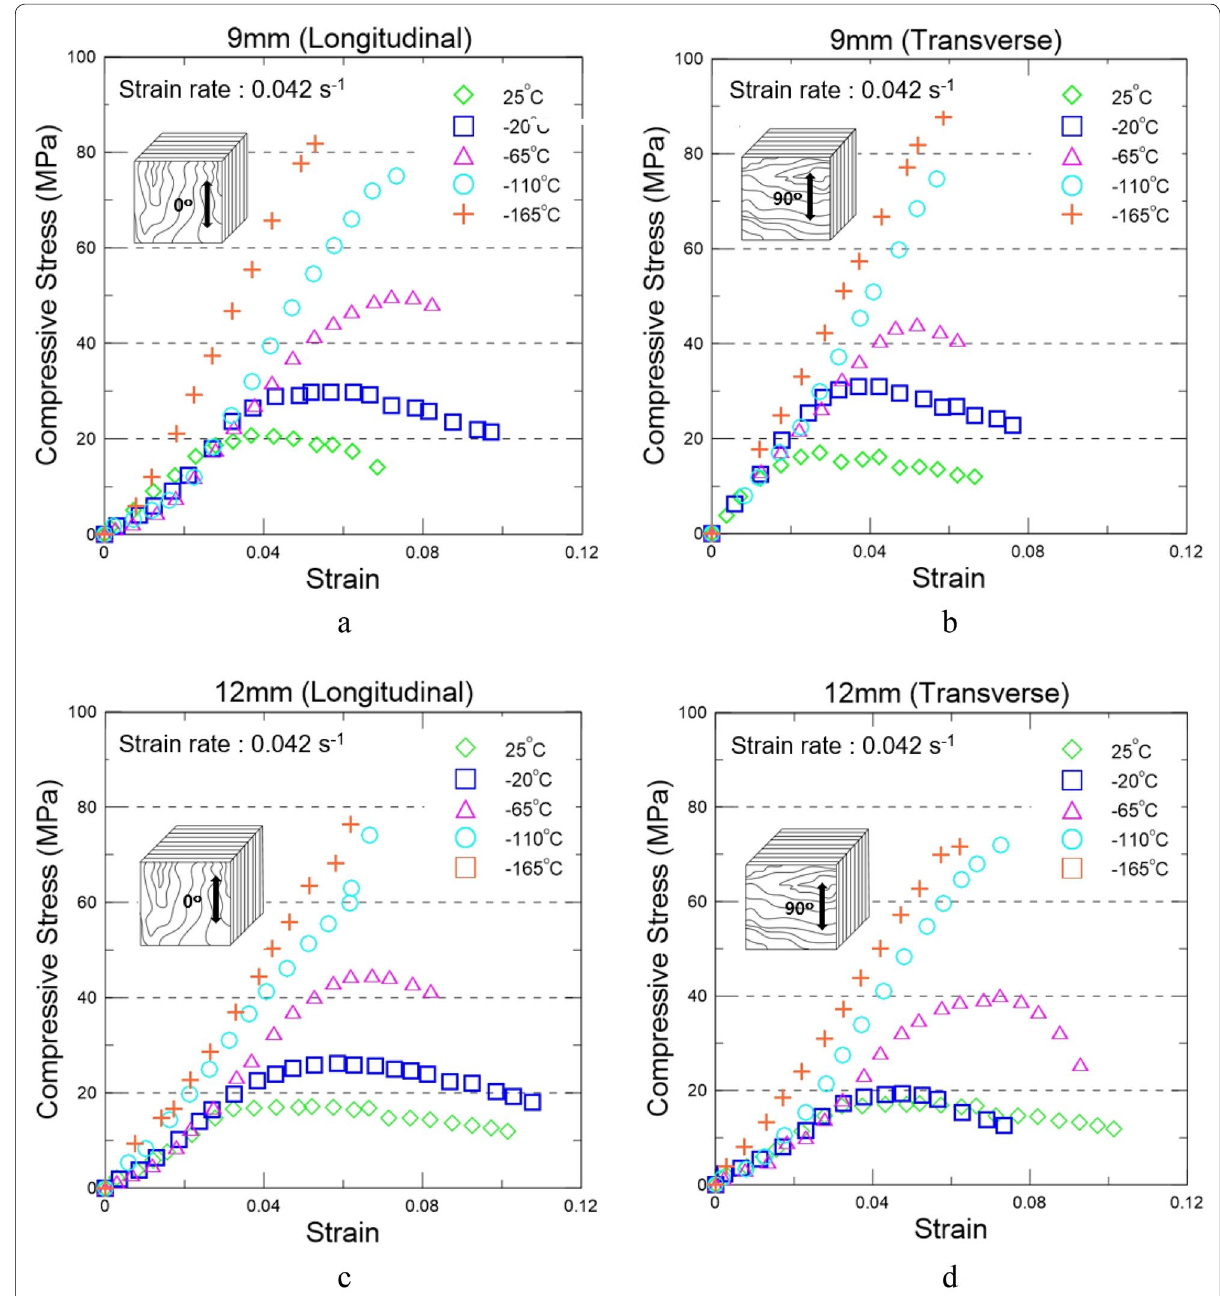
Fig. 7 Compressive test results of plywood specimens in longitudinal fiber direction for a 9 mm and in transverse fiber direction for b 9 mm thicknesses and in longitudinal fiber direction for c 9 mm and in transverse fiber direction for d 12 mm